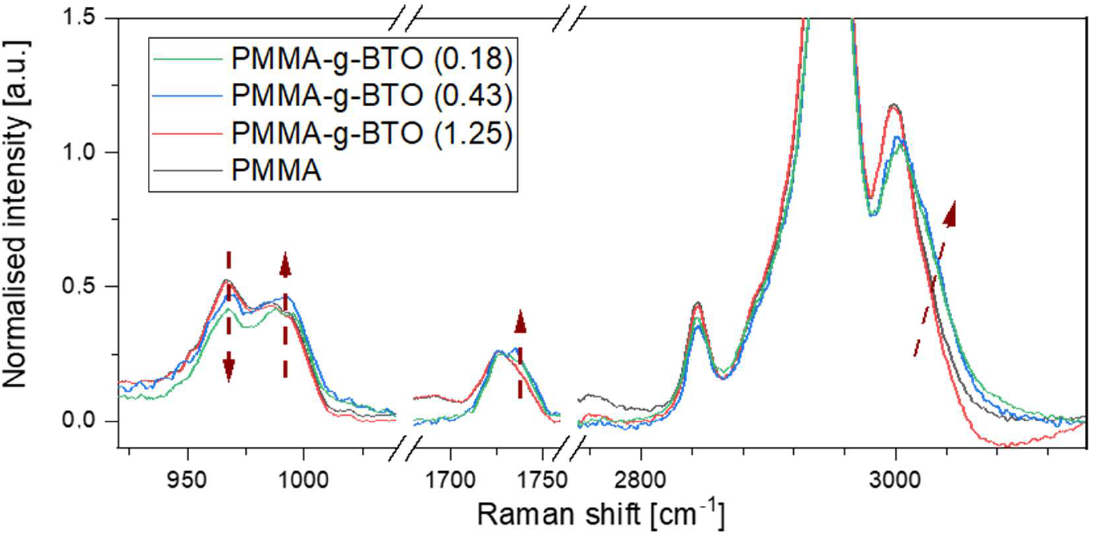
Figure 9. Raman spectra of BTO- g -PMMA nanocomposites at some selected